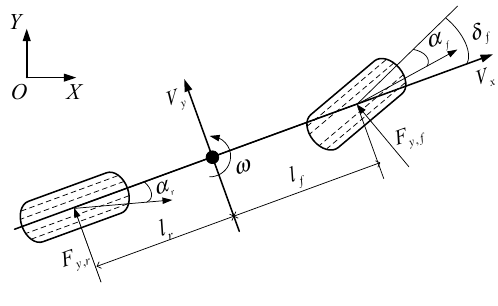
Figure 1. The overall structure of the proposed hierarchical estimation method.